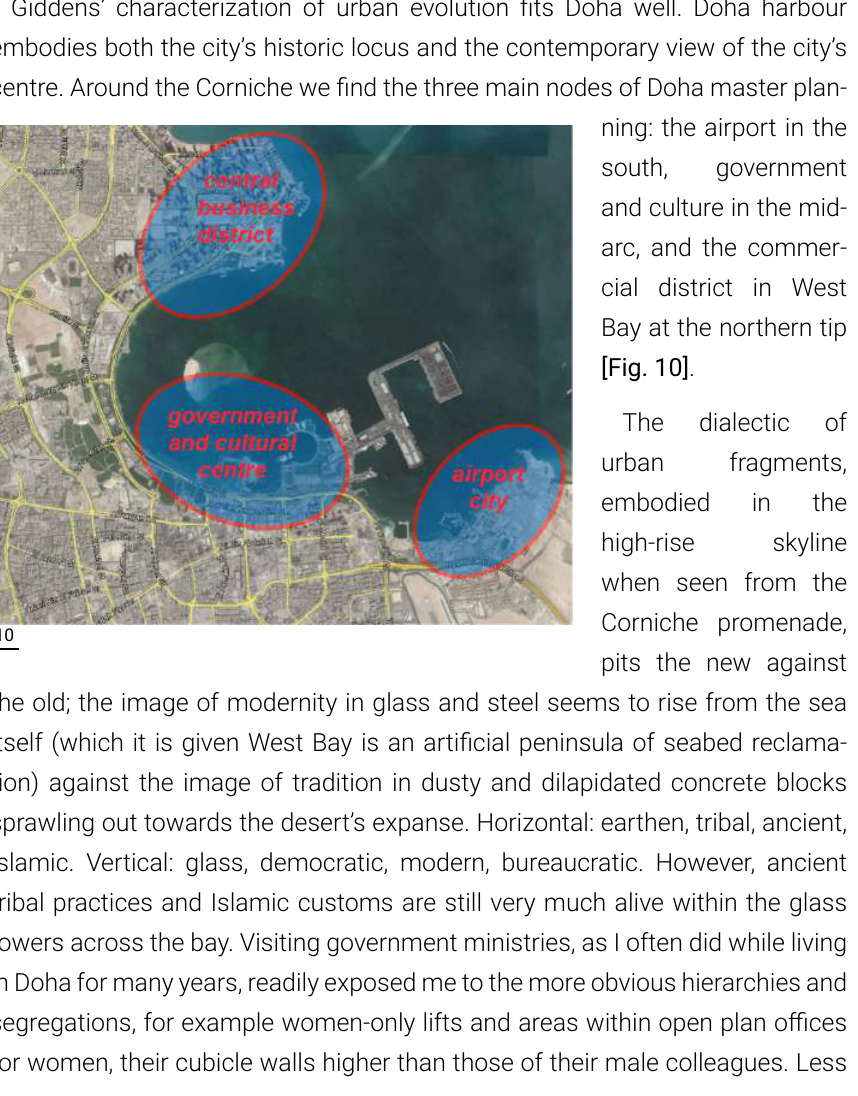
Fig. 10 Map of Doha harbour highlight - ing the three primary zones of activity (Source: Google Earth,